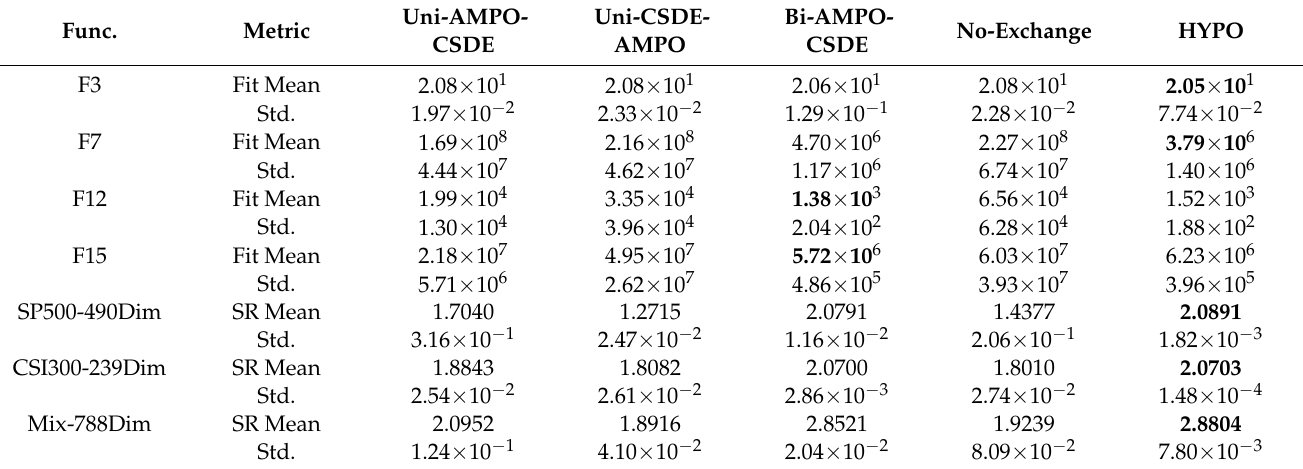
Table 9. Comparative Results on Different Settings of Transition Directions.